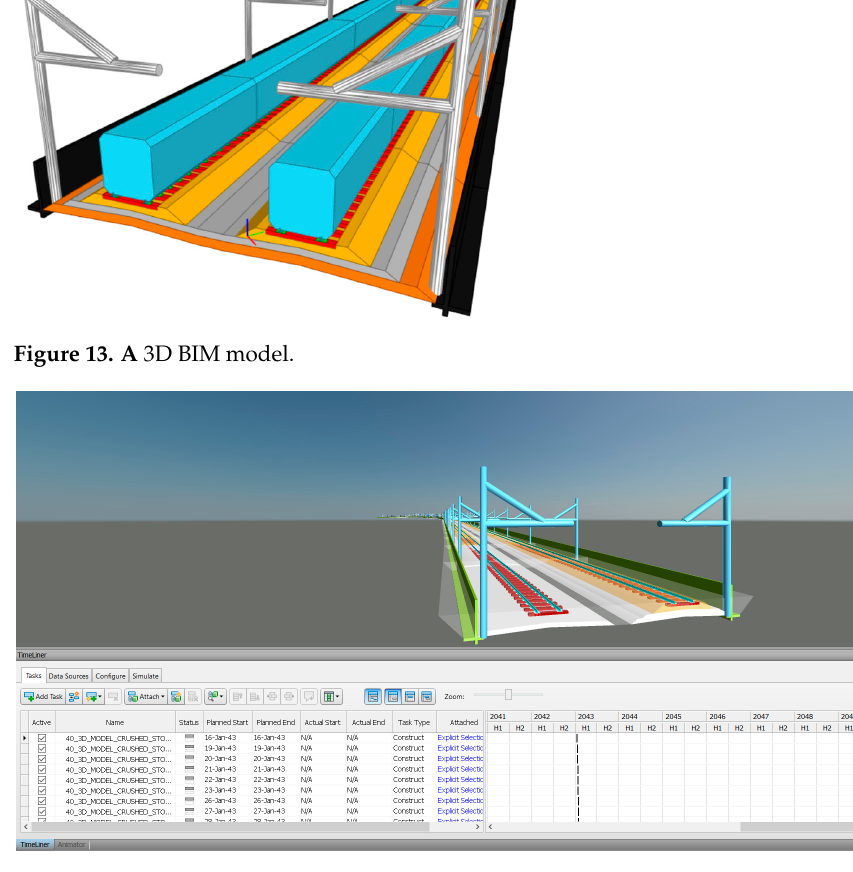
Figure 14. Railway BIM model imported to Navisworks for scheduling.